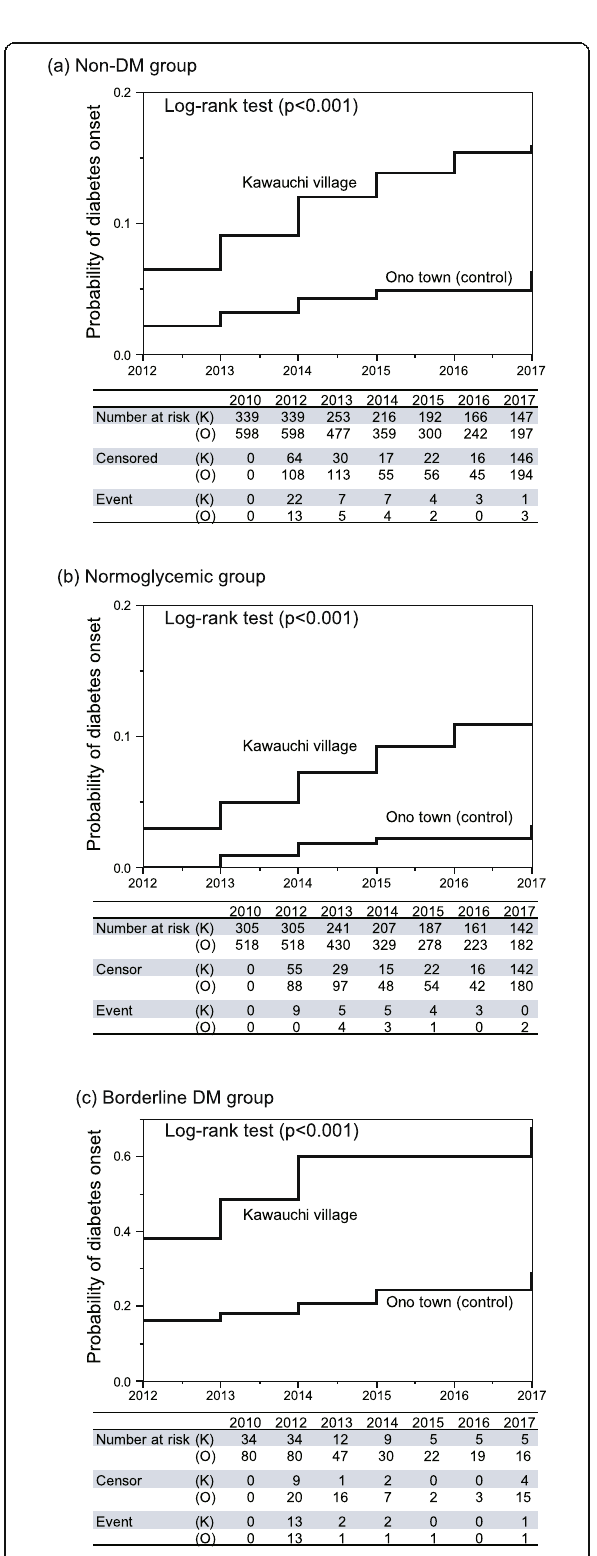
Fig. 3 Kaplan-Meier curves and the results of log-rank tests comparing the occurrence of diabetes mellitus (DM) between Kawauchi village and Ono town: ( a ) Non-diabetic group (borderline DM + normoglycemic), ( b ) normoglycemic group, and ( c ) Borderline